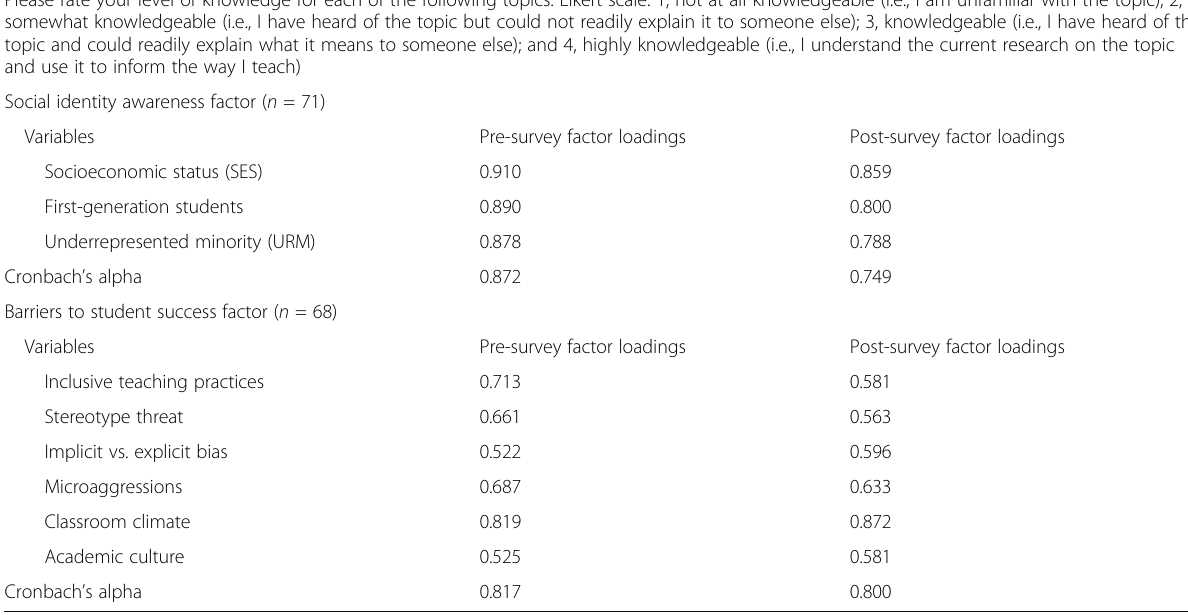
Table 4 Exploratory factor analysis of pre-survey and post-survey items Prompt for each pre- and post-survey item (variables): Please rate your level of knowledge for each of the following topics. Likert scale: 1, not at all knowledgeable (i.e., I am unfamiliar with the topic); 2, somewhat knowledgeable (i.e., I have heard of the topic but could not readily explain it to someone else); 3, knowledgeable (i.e., I have heard of the topic and could readily explain what it means to someone else); and 4, highly knowledgeable (i.e., I understand the current research on the topic and use it to inform the way I